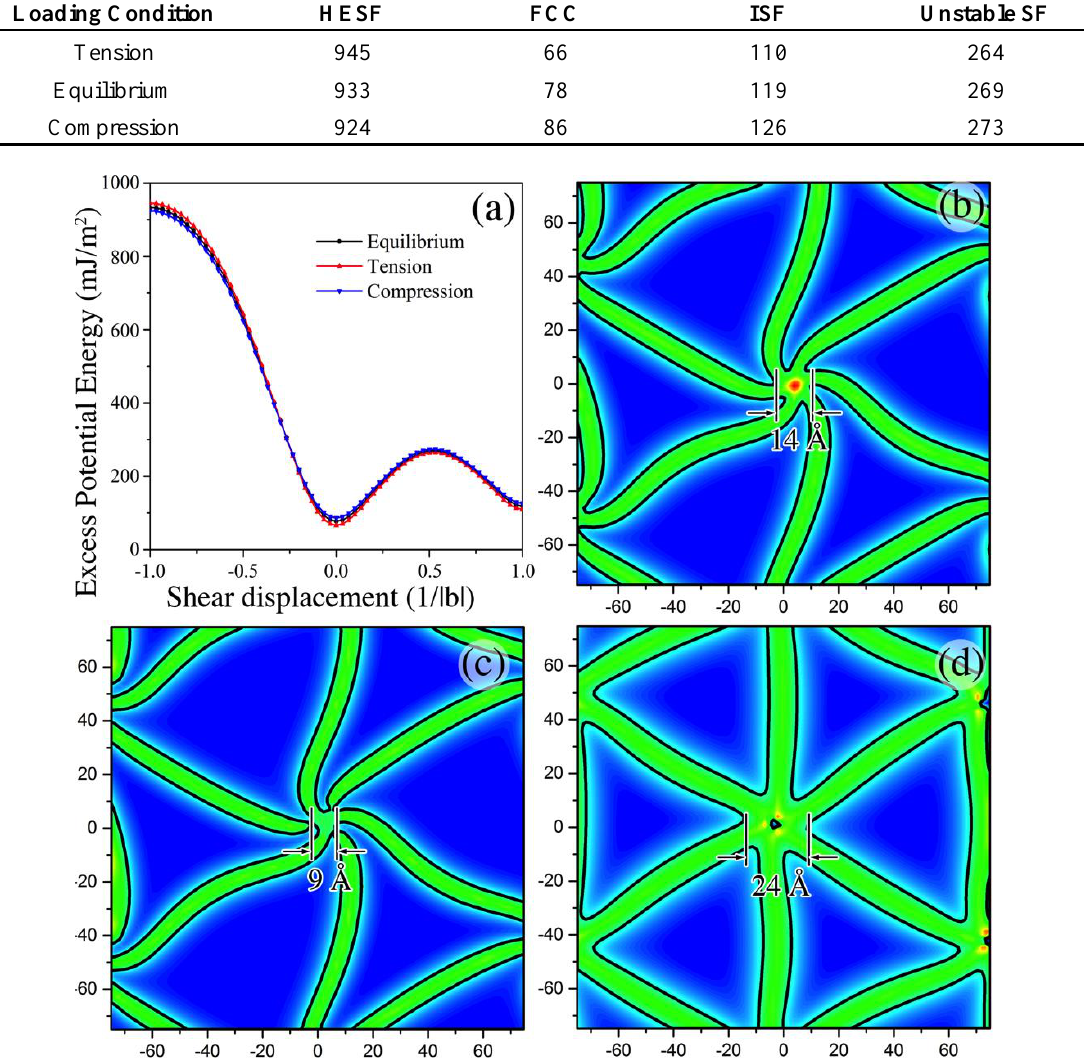
Figure 3. The variations in the misfit dislocation pattern of the (111) Cu–Ni semi-coherent interface due to loading. ( a ) shows the variation in the generalized stacking fault energy profile due to loading; ( b – d ) show the misfit dislocation pattern under equilibrium, tension and compression,